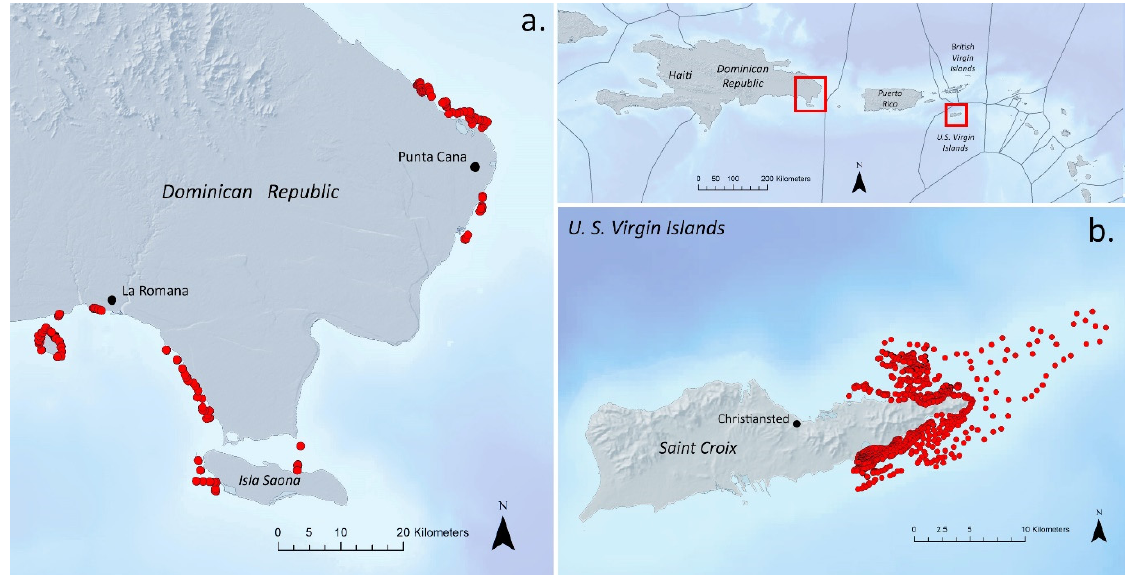
Figure 6. A total of 1653 GPS-referenced field data points representing locations of underwater video transects were used to train the algorithm within ( a ) eastern Dominican Republic (281 points); and ( b ) Saint Croix, USVI (1372 points).